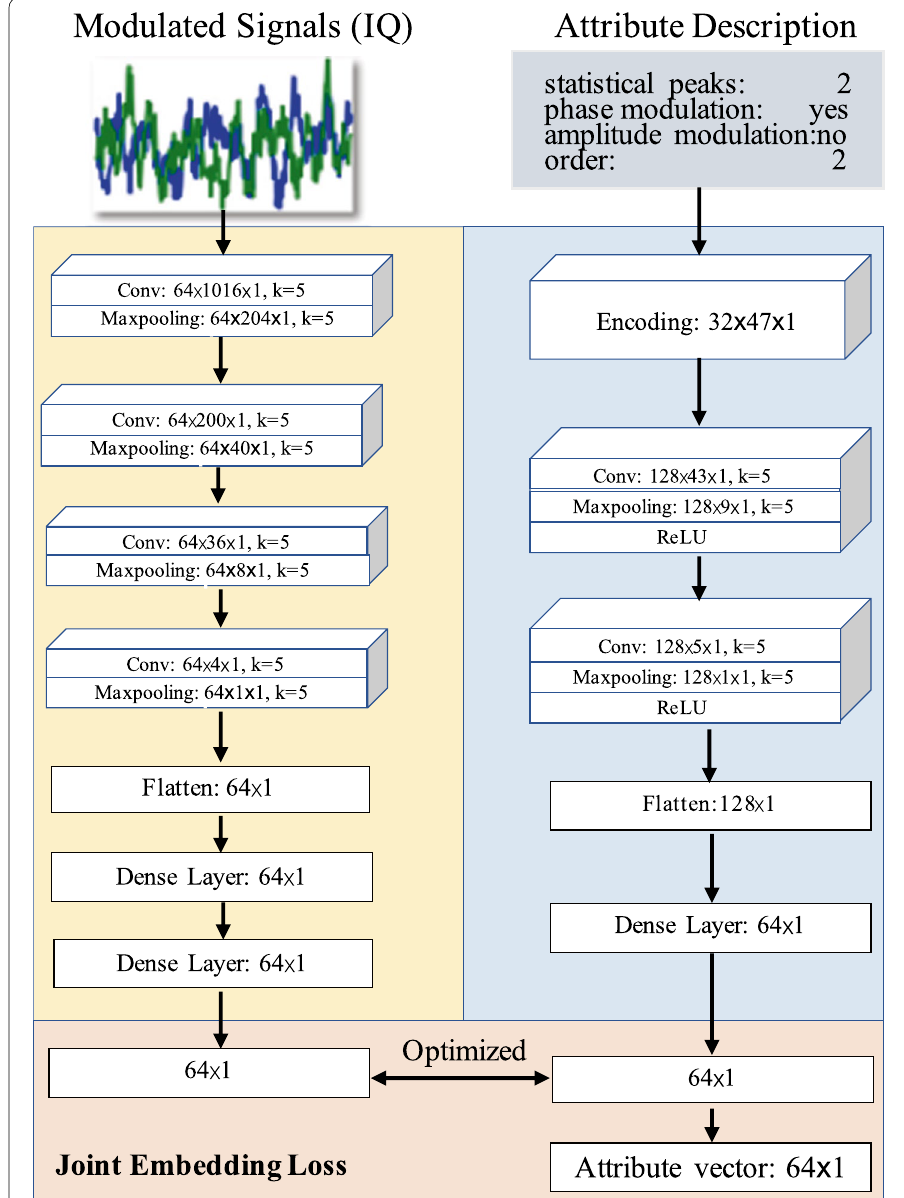
Fig. 3 The generation module of semantic attribute vector. The left part is the convolutional module and the right part is the convolutional encoding